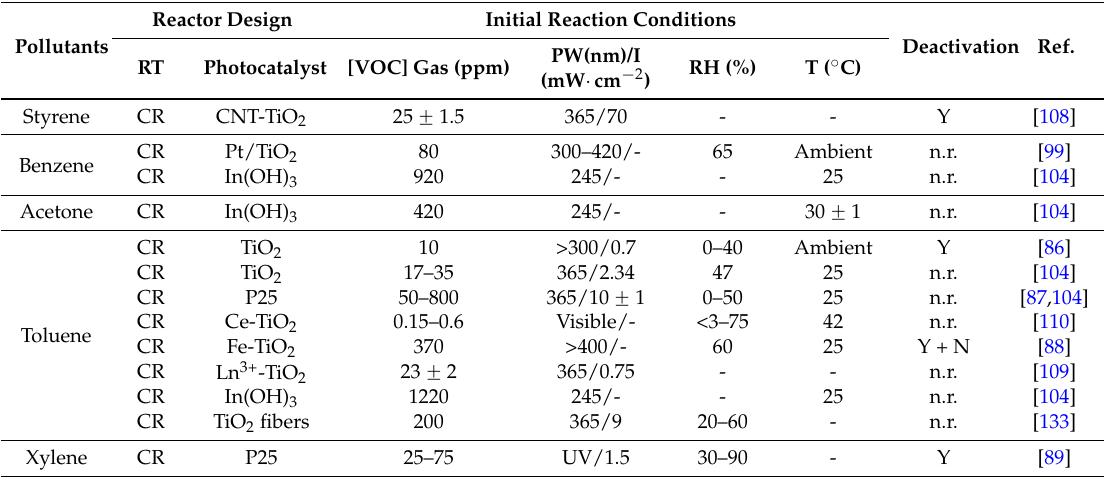
Table 6. Kinetic parameters and PCO conversion efficiency (%) for the common